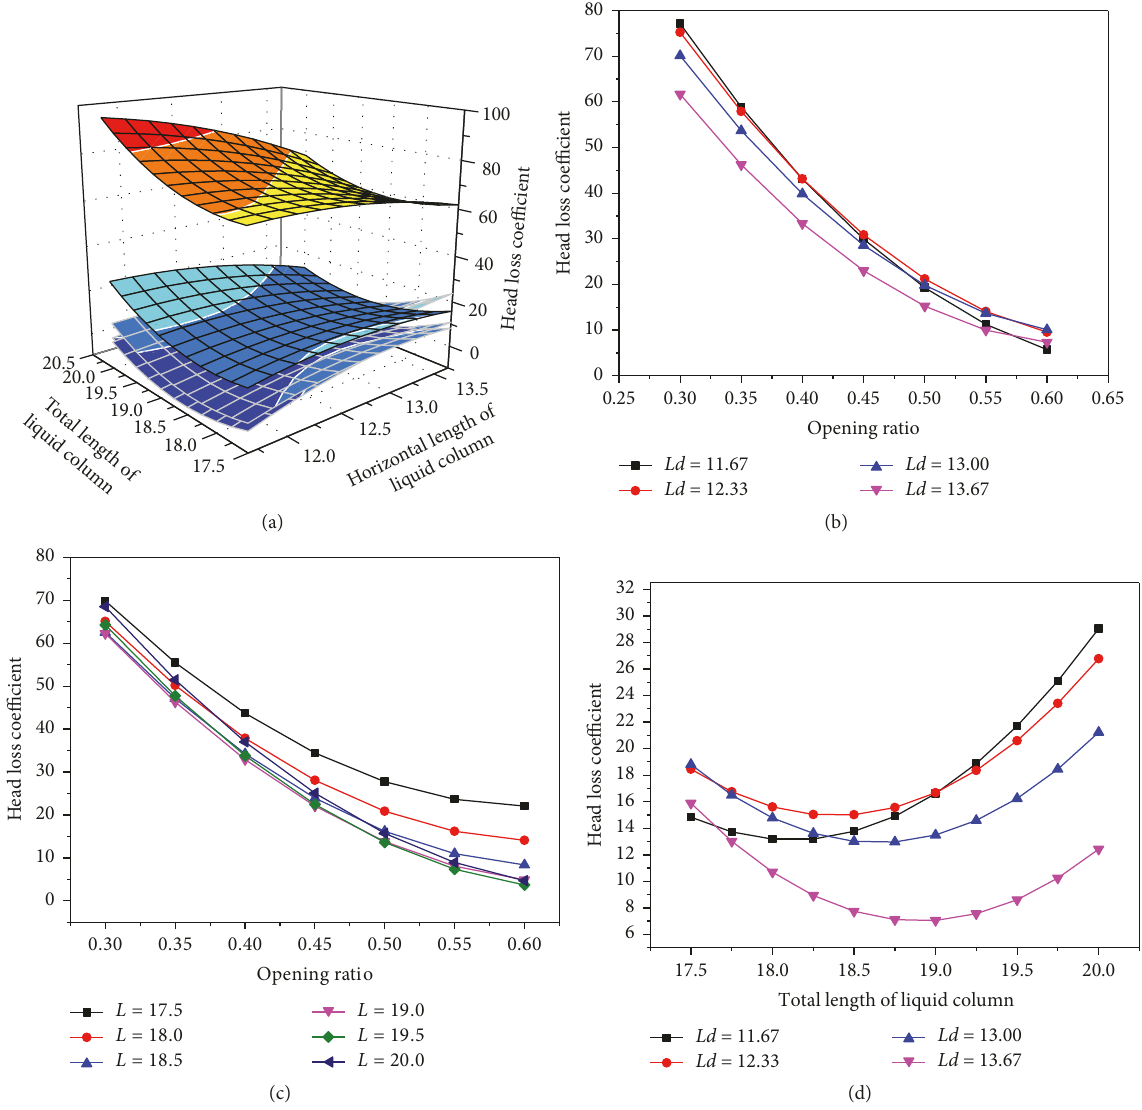
Figure 10: Relation schema of total length of liquid column–opening rate–horizontal length of liquid column.